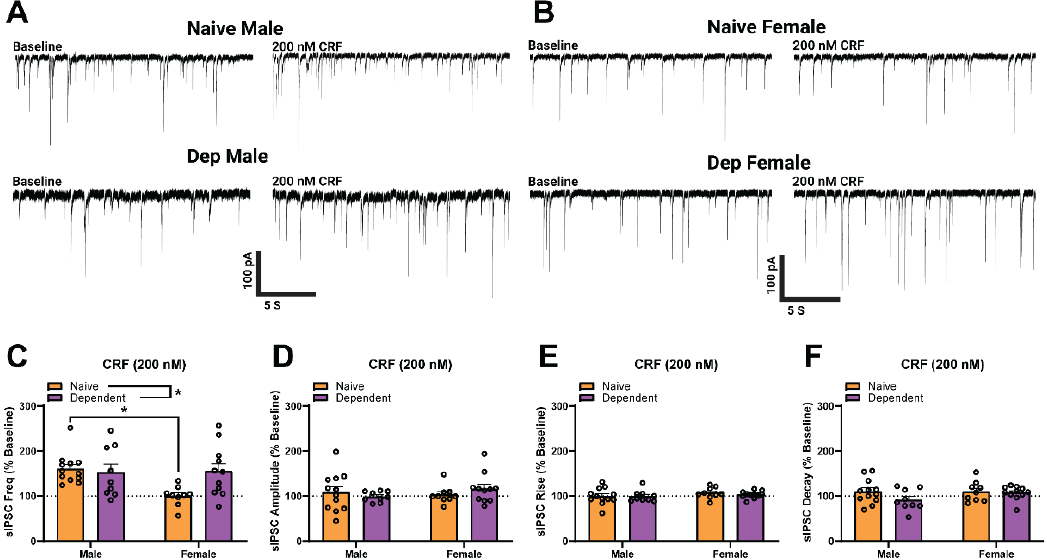
Figure 2. GABAergic transmission in the central amygdala (CeA) of naïve females is insensitive to corticotropin releasing factor (CRF) compared to males. ( A , B ) Representative GABA A -mediated sIP- SCs from CeA neurons of naïve ( upper ) and dependent ( lower ) male ( A ) and female ( B ) rats at baseline ( left ) and during acute application of CRF (200 nM; right ). ( C ) Acute CRF increases CeA sIPSC frequency in naïve (160.4 ± 9.8% of baseline) and dependent (157.1 ± 18.2% of baseline) males. Acute CRF has no effect on sIPSC frequency in naïve (100.3 ± 7.3% of baseline) females but increases sIPSC frequency in dependent (155.0 ± 16.9% of baseline) females. For sIPSC frequency, the main effect of Alcohol Exposure was observed, as well as a significant interaction effect between Sex × Alcohol Exposure but no main effect of Sex. There were no significant differences in sIPSC ampli- tude ( D ), rise time ( E ), or decay time ( F ) during acute CRF application across groups. Differences in sIPSC properties were assessed using two-way ANOVA test with a post-hoc Šídák’s correction for multiple comparisons where * denotes p < 0.05. Bars represent Mean ± SEM; n = 9–12 neurons per group; N = 5–8 rats per group.